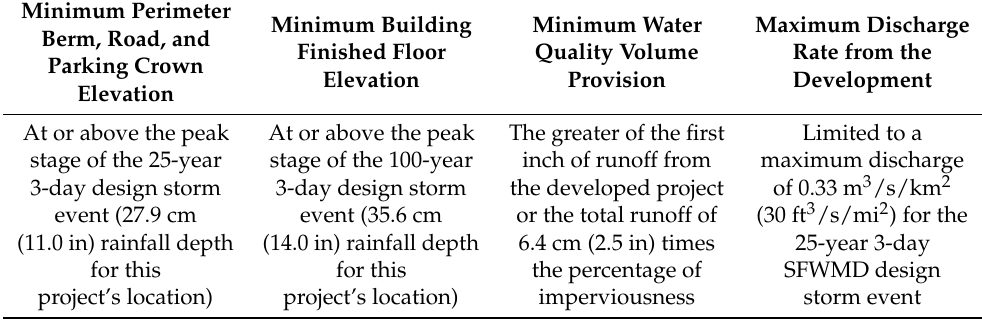
Table 1. LA-MSID permitting criteria